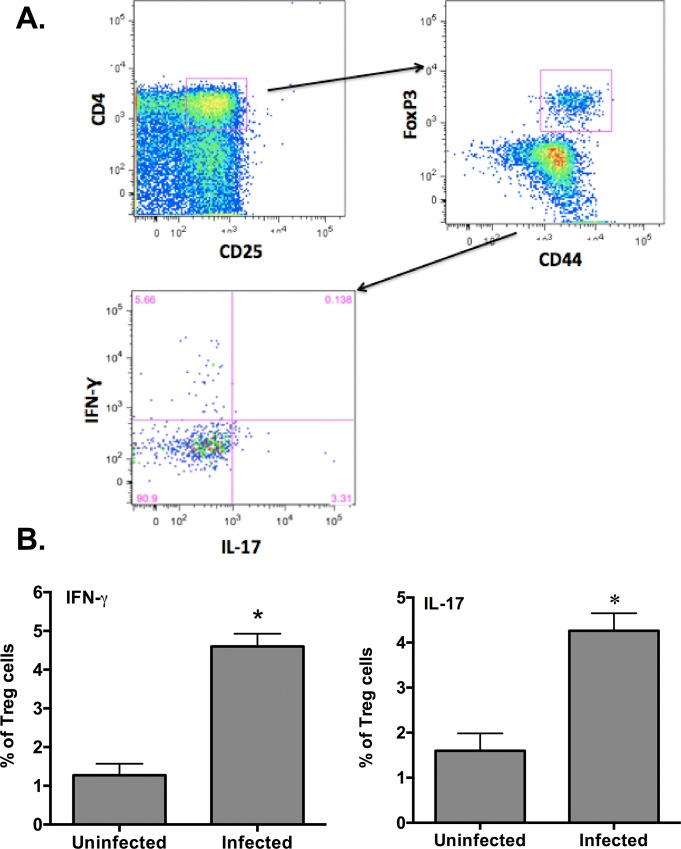
IL-17+ and IFN-γ+ populations of Treg (CD4+CD25+FoxP3+) cells expand in LRN after mycoplasma infection.Mice were infected with M. pulmonis, and 7 days later, cells were isolated from LRN after infection. The cells were immunofluorescently stained for the expression of CD4 and CD25, and intracellular FoxP3, IL-17 and IFN-γ. (A) CD4+CD25+FoxP3+ CD44+ (Treg) cells were identified and gated for determination of IL-17 and IFN-γ expressing cells. Double positive (IFN-γ+IL-17+) Treg cells were not found. (B) The percentage of IFN-γ+ Treg cells and IL-17+ Treg cells increased in the LRN of mycoplasma infected mice. No changes in these cell populations were found in lungs (P > 0.05). An asterisk (*) represents a significant (P ≤ 0.05) difference between infected versus uninfected mice. Vertical bars and error bars represent means +/- SE (n = 6).